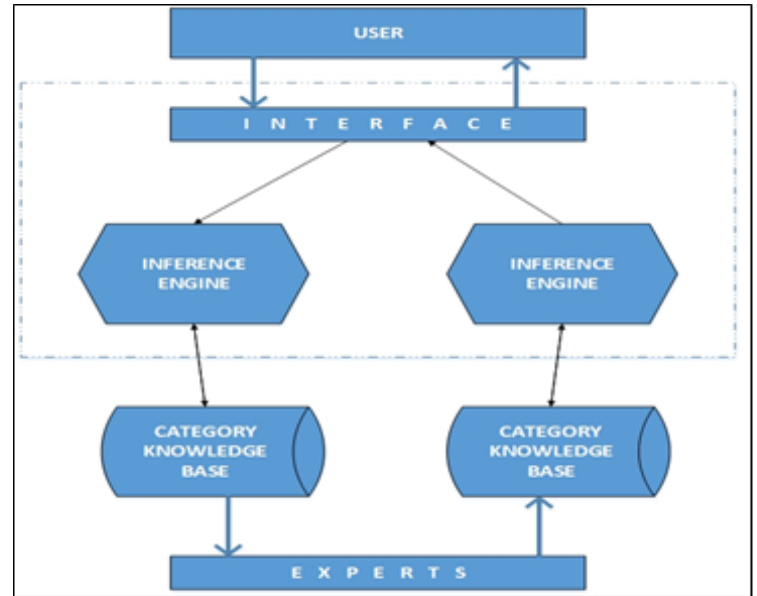
Figure 1. Architecture of the proposed